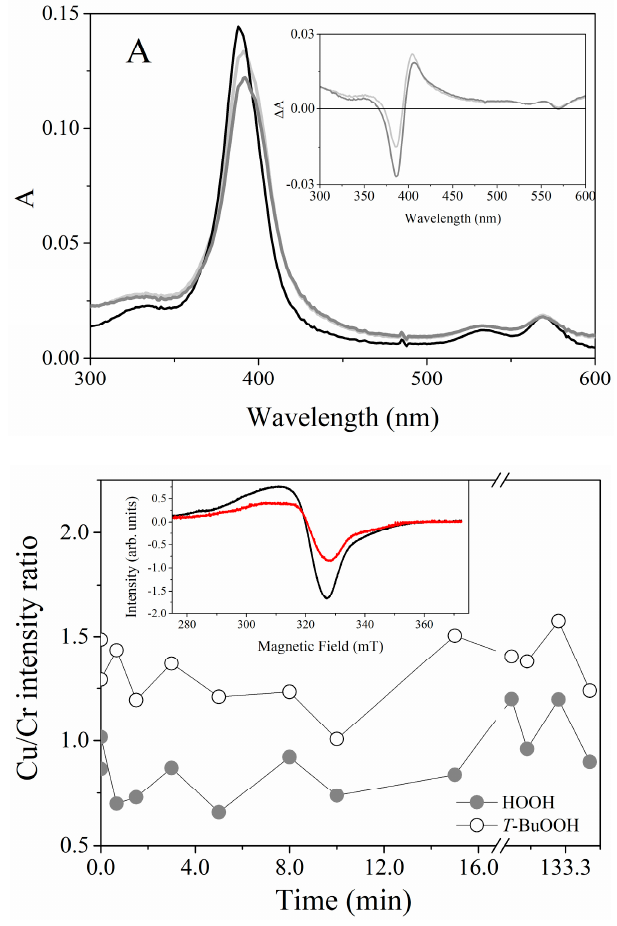
Figure 8. Cu(II)MP-11 peroxidase activity. ( A ) Time-resolved UV-visible spectra of 1 µM Cu(II)MP-11 during the reaction with 0.8 mM HOOH at 5 mM HEPES buffer solution, pH 7.4. The decreasing intensity spectra correspond to zero, 12 (light gray line) and 15 min (gray line) after hydrogen peroxide addition. The inset corresponds to the differential spectra obtained by subtracting the initial time from the spectra obtained after 12 min (light gray line) and 15 min (gray line) of the reaction; ( B ) EPR from Cu(II)MP-11 peroxidase activity using Cr(III) as a signal marker. The reactions were done in the presence of HOOH (gray circle) or t -BuOOH (open circle). The inset shows the first spectra (time zero) and after 70 min of t -BuOOH addition. Experimental conditions: 0.1 mM Cu(II)MP-11, 0.3 mM of peroxides, water buffered solution, gain 50 dB, modulation amplitude 1 mT, power microwave 2.5 mW, frequency microwave 9.48 GHz, the time constant 20 ms, conversion time 81.92 s, temperature 10 K.